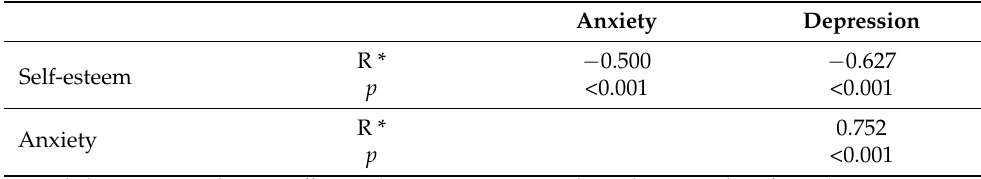
Table 4. Correlations between self-esteem, anxiety, and depression for all participants ( n = 300).